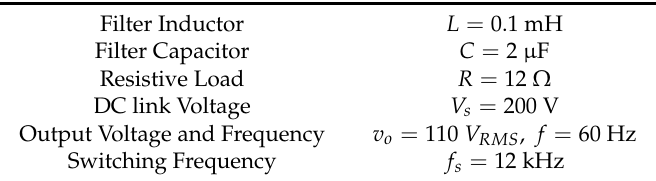
Table 1. VSI system